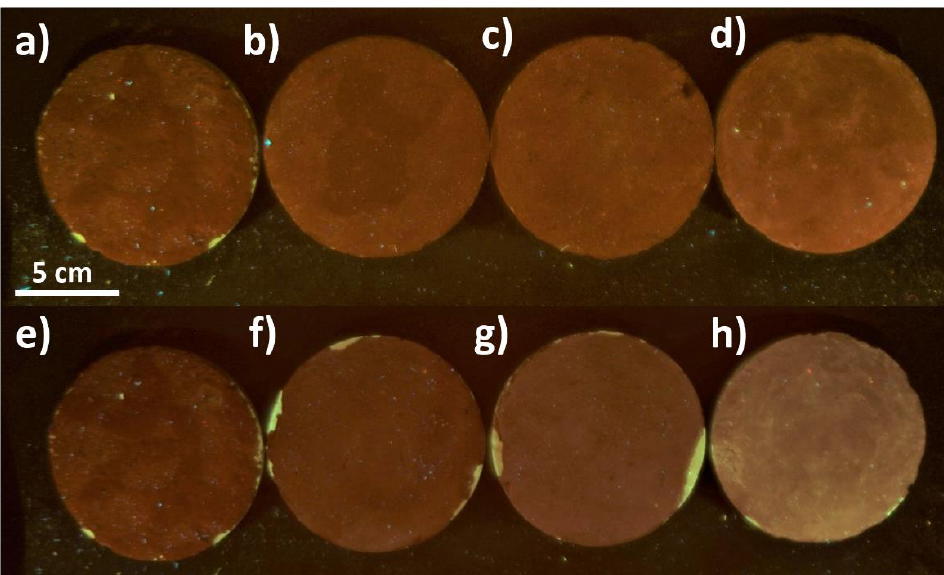
Figure 3. Photographs of samples under UV light: untreated ( a , e ); treated with PRO-ART with ( b ) 1 application, ( c ) 2 applications, and ( d ) 3 applications; and treated with AG09W with ( f ) 1 application, ( g ) 2 applications, and ( h ) 3 applications .